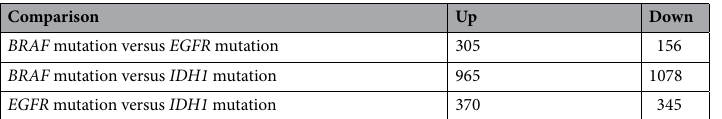
Table 1. Differentially expressed gene count in comparisons of three molecularly distinct sub-types of glioblastoma.